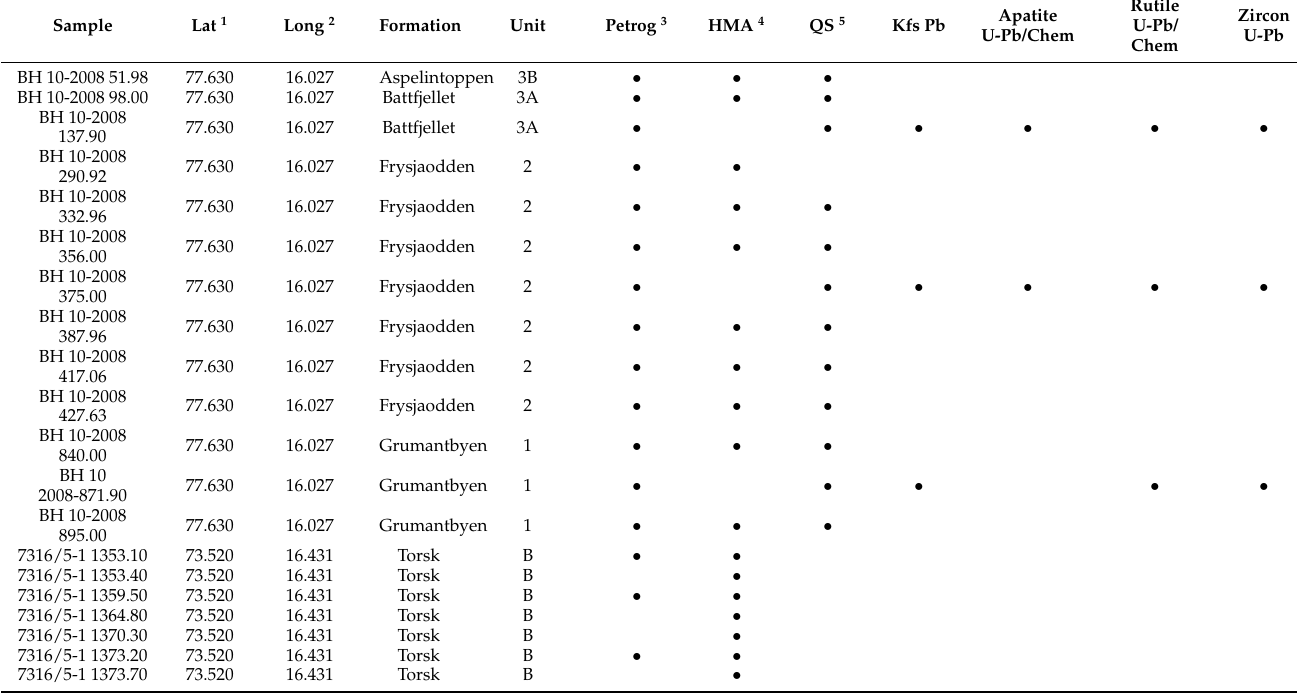
Table 1. Sample and analysis